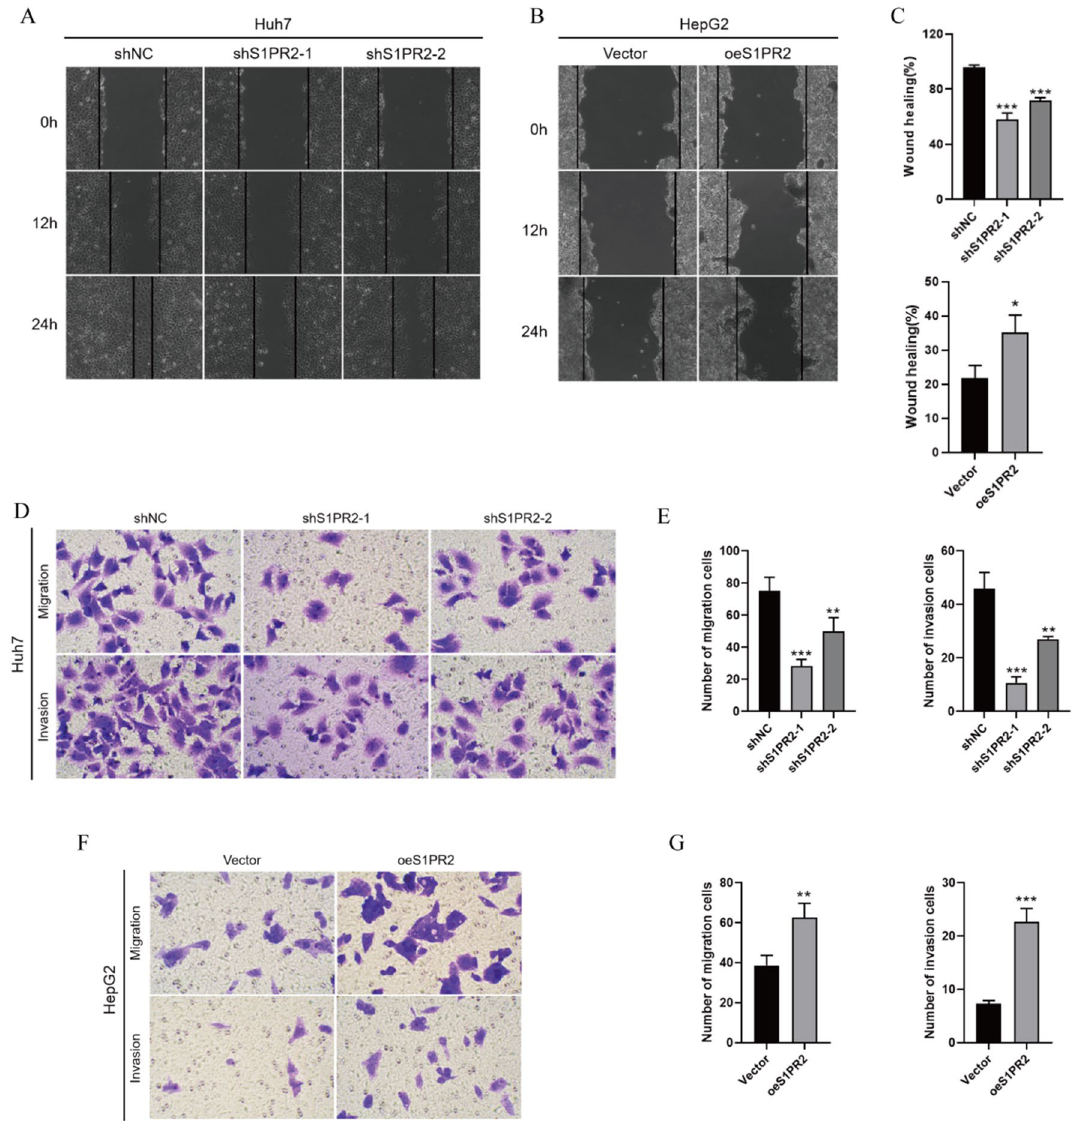
Fig. 3 A , B , and C Migration effect of S1PR2 on HCC cells and statistical analysis of related migration rate. D , E Migration and invasion of cells detected by Transwell after transfection of Huh7 cells with S1PR2 interference plasmid and related statistical analysis; F , G Migration and invasion of cells detected by Transwell after transfection of HepG2 cells with S1PR2 overexpression plasmid and related statistical analysis; **p < 0.01, ***p <